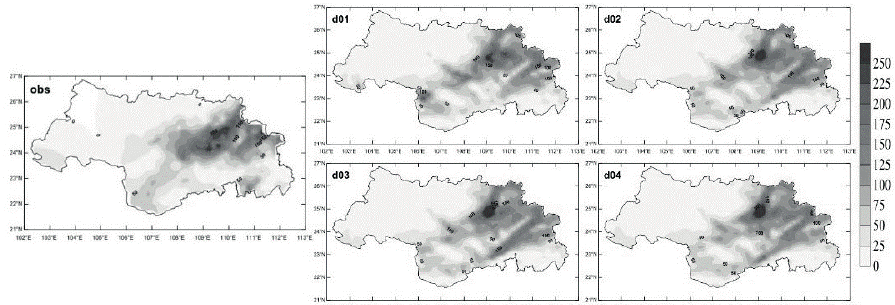
Fig. 3 Comparison of observed and simulated precipitation at different domain size for Storm 3.